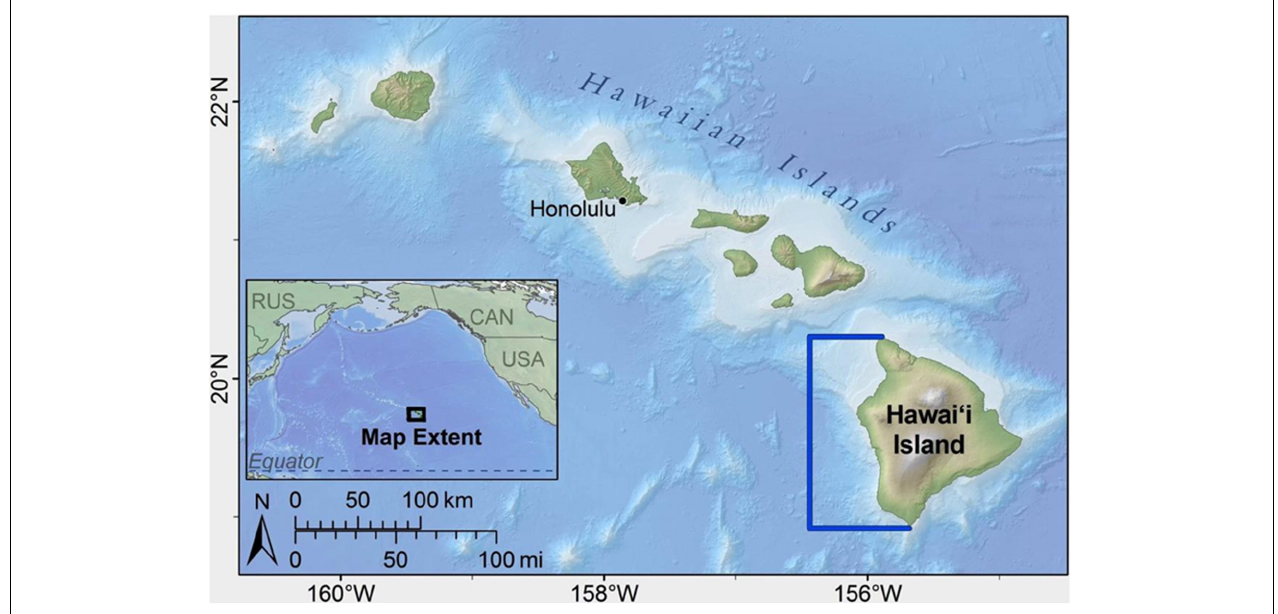
FIGURE 1 | Approximate geographic extent (blue line) of the West Hawai‘i Integrated Ecosystem Assessment. Source: Joey Lecky, Pacific Islands Fisheries Science Center, and NMFS.